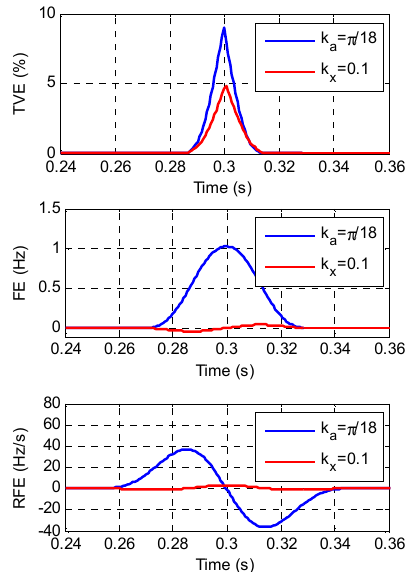
Figure 5. The maximum TVE, FE, and RFE under step changes in phase angle and magnitude.